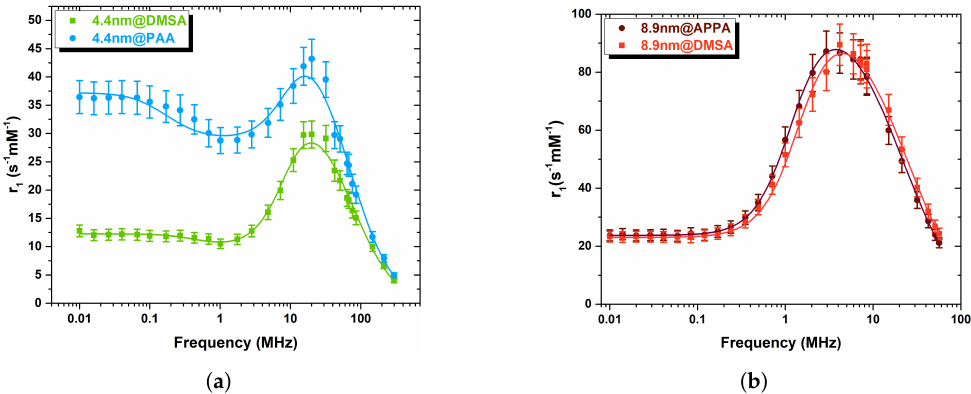
Figure 9. Fit to the heuristic model of Roch-Müller-Gillis of the longitudinal relaxivity 1 H-NMRD profiles of ( a ) 4.4 nm samples (coated with DMSA and PAA), and of ( b ) 8.9 nm ones (coated with DMSA and APPA); the data have been collected at room temperature.